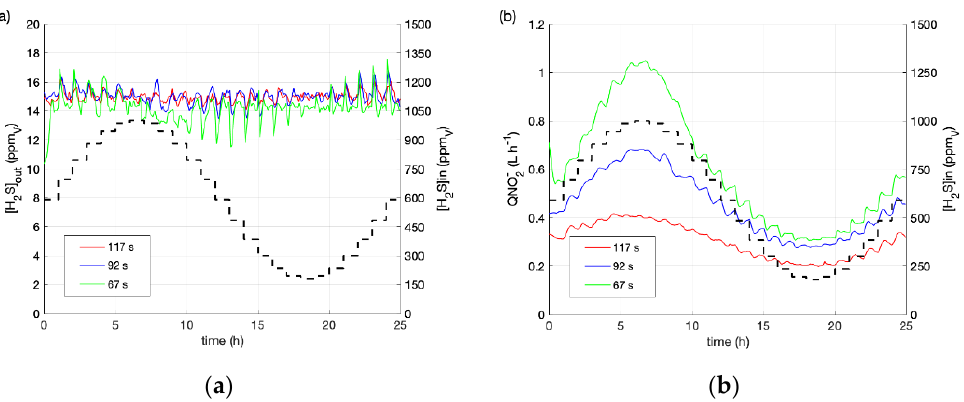
Figure 4. Profiles obtained in EBRT studies at 67 s, 92 s and 117 s. ( a ) H 2 S outlet concentration, ( b ) nitrite flowrate. Green lines: 67 s; blue lines: 92 s; red lines: 117 s; dashed black lines: H 2 S in .